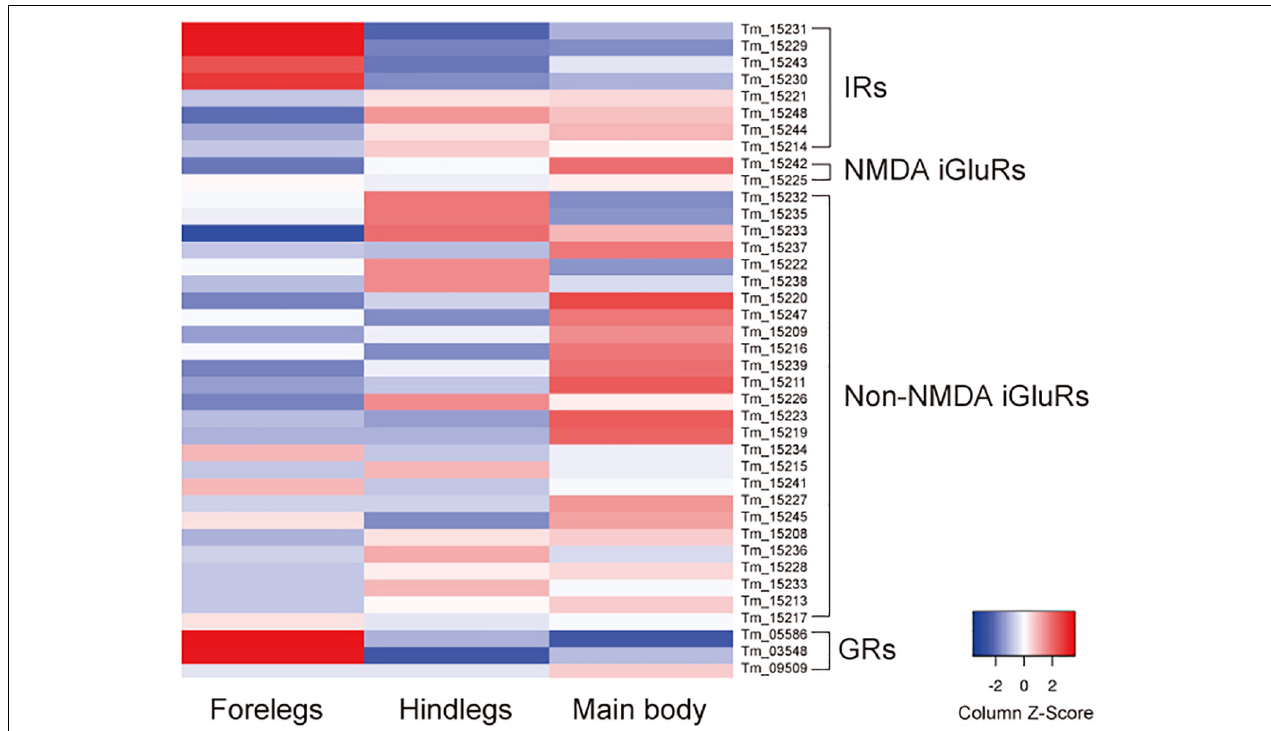
FIGURE 2 | Expression of ionotropic receptors (IRs), NMDA iGluRs, non-NMDA iGluRs, and gustatory receptors (GRs) mRNAs in the forelegs, hindlegs, and main body of T. mercedesae. The level of expression of each mRNA in the forelegs, hindlegs, and main body is shown by a graded color (blue to red) based on the counts per million mapped reads (CPM).